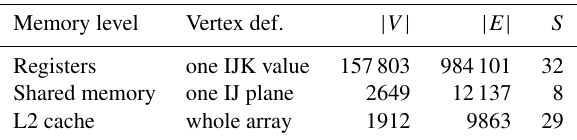
Table A1. COSMO CDAGs at various GPU memory hierarchy lev- els. Memory level Vertex